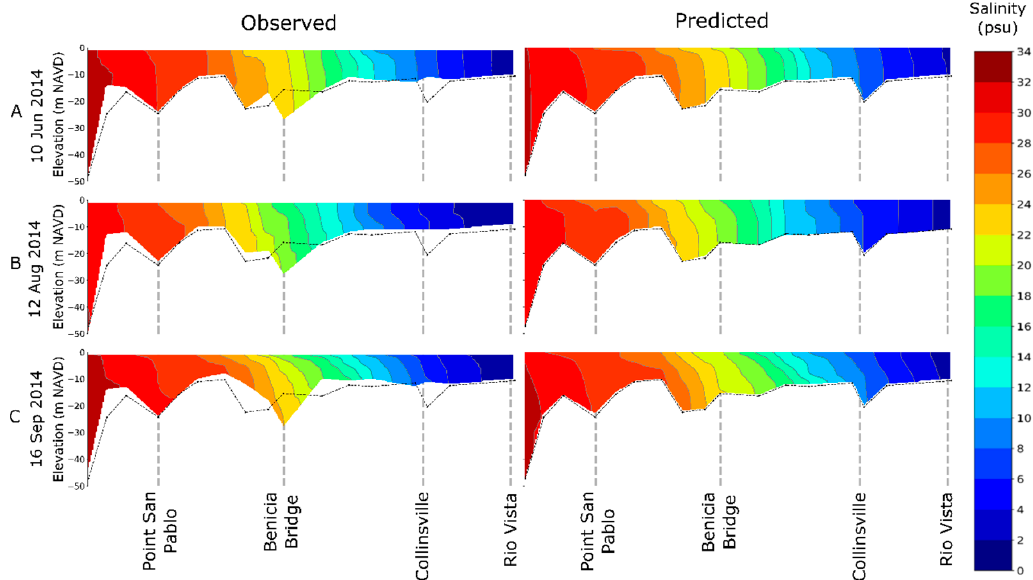
Figure 4. Observed and predicted salinity transects from the Golden Gate to Rio Vista at all dates available during the simulation period: ( A ) 10 June 2014, ( B ) 12 August 2014, and ( C ) 16 September 2014. The black line indicates model bathymetry along transect.